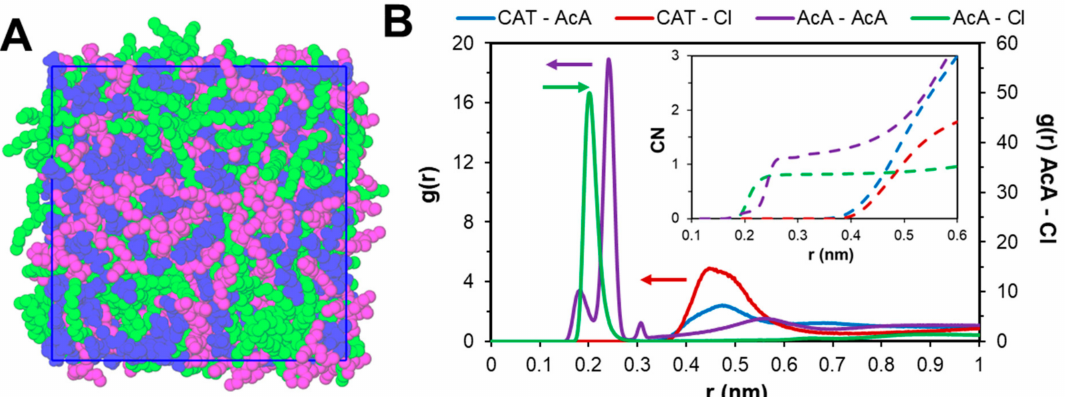
Figure 2. ( A ) Snapshot of the equilibrated [P 44414 ]Cl + CH 3 COOH system with chloride anion and acetic acid in blue and C 4 and C 14 alkyl chains of [P 44414 ] + in purple and green respectively. ( B )